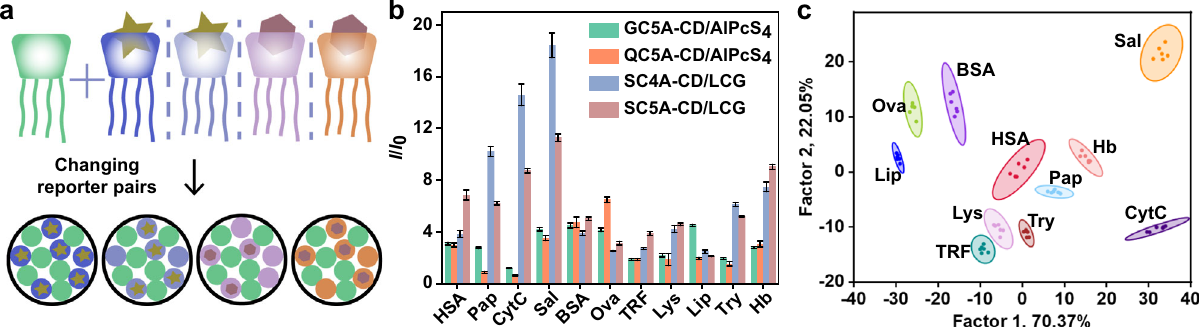
Fig. 3 Construction and experimental results of sensor array based on different reporter pairs. a Schematic diagram of SA1 . Pattern recognition of proteins using SA1 ([CA] = [CD] = 1.0 μ M, [dye] = 1.0 μ M). b Fluorescence response patterns of SA1 against various proteins (23.8 μ g/mL for each protein). The order of colored symbols from top to bottom in the legend corresponds to the column order of histogram from left to right. c Canonical score plot for the two factors of simpli fi ed fl uorescence response patterns obtained from LDA with 95% con fi dence ellipses. All experiments were performed in water (pH = 6.53) and pH only slightly changed after the addition of proteins (Supplementary Table 2). The fl uorescence spectra of dyes were recorded and kept almost unchanged in the presence of NaClO 4 (up to 27.5 mM, Supplementary Fig. 26) in order to exclude the effect of ionic strength. Error bars in b represent mean ± s.d. ( n = 6 independent